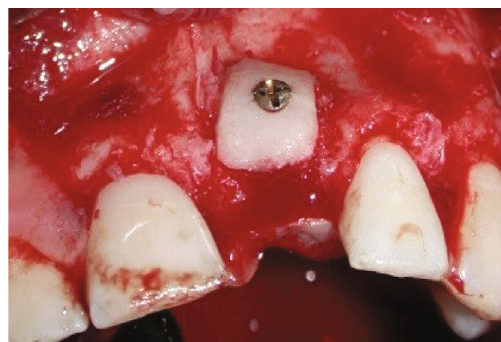
Figure 3: Onlay grafting procedure in case no. 1: ZB graft placed in direct contact with the recipient site and stabilized with a miniscrew.